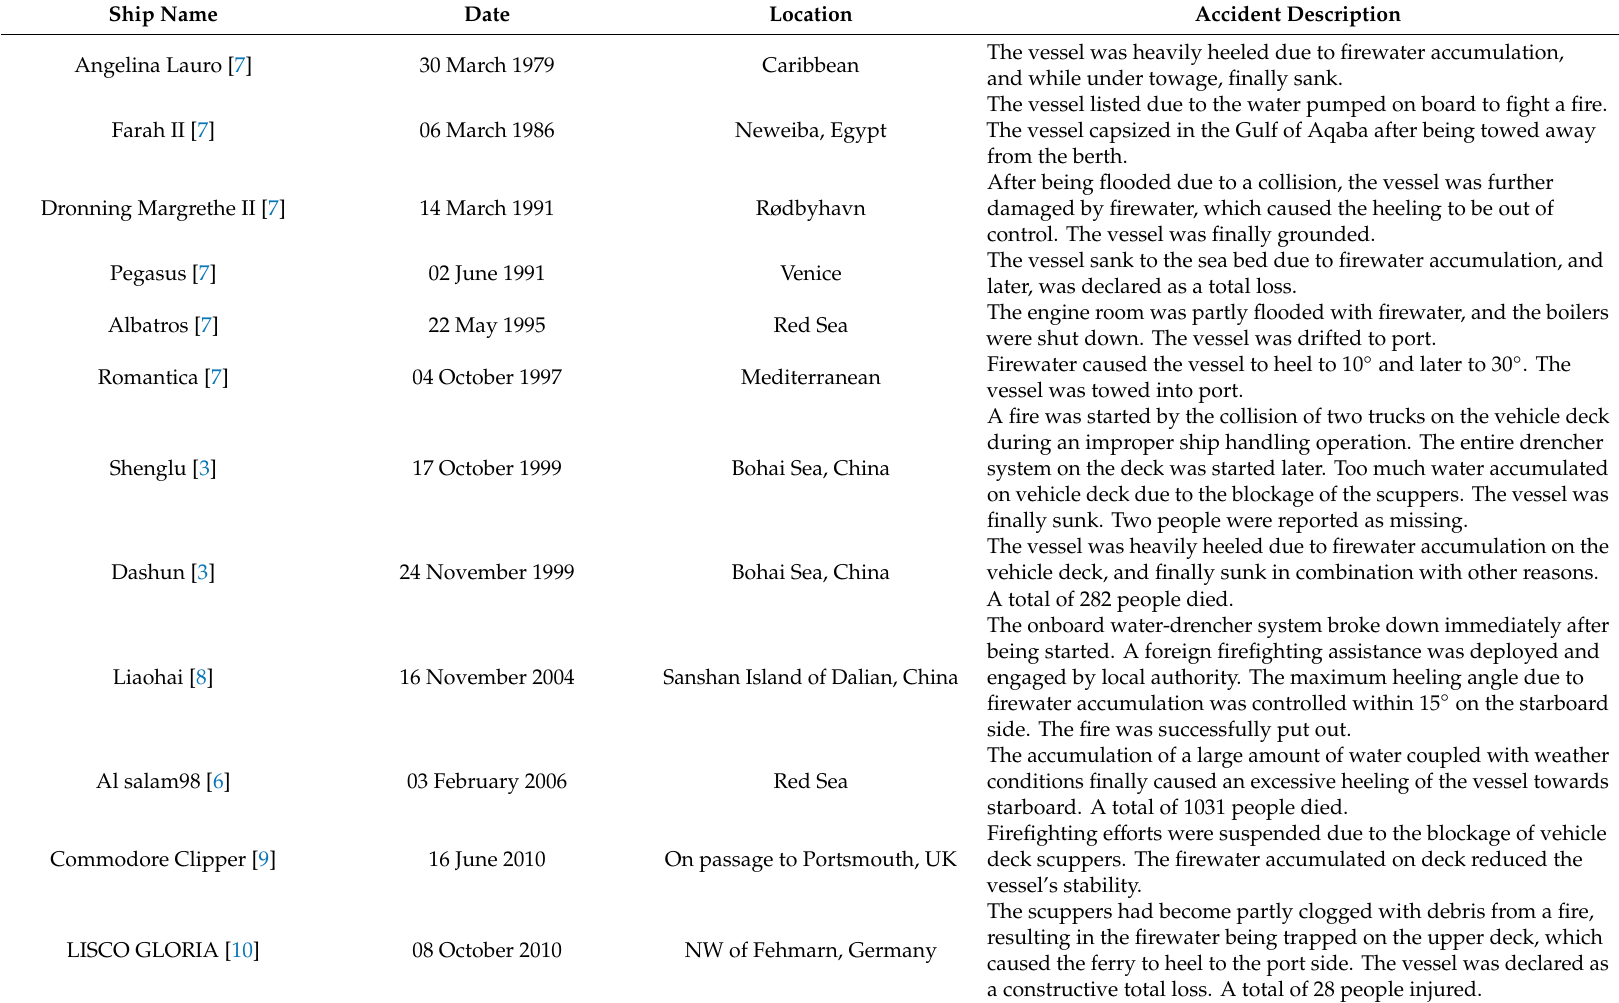
Table 1. Accidents of roll on / roll o ff cargo (ROPAX) vessels involving firewater accumulation over last 40 years (Source: DNV-GL, MSA, MAIB, FBMCI,